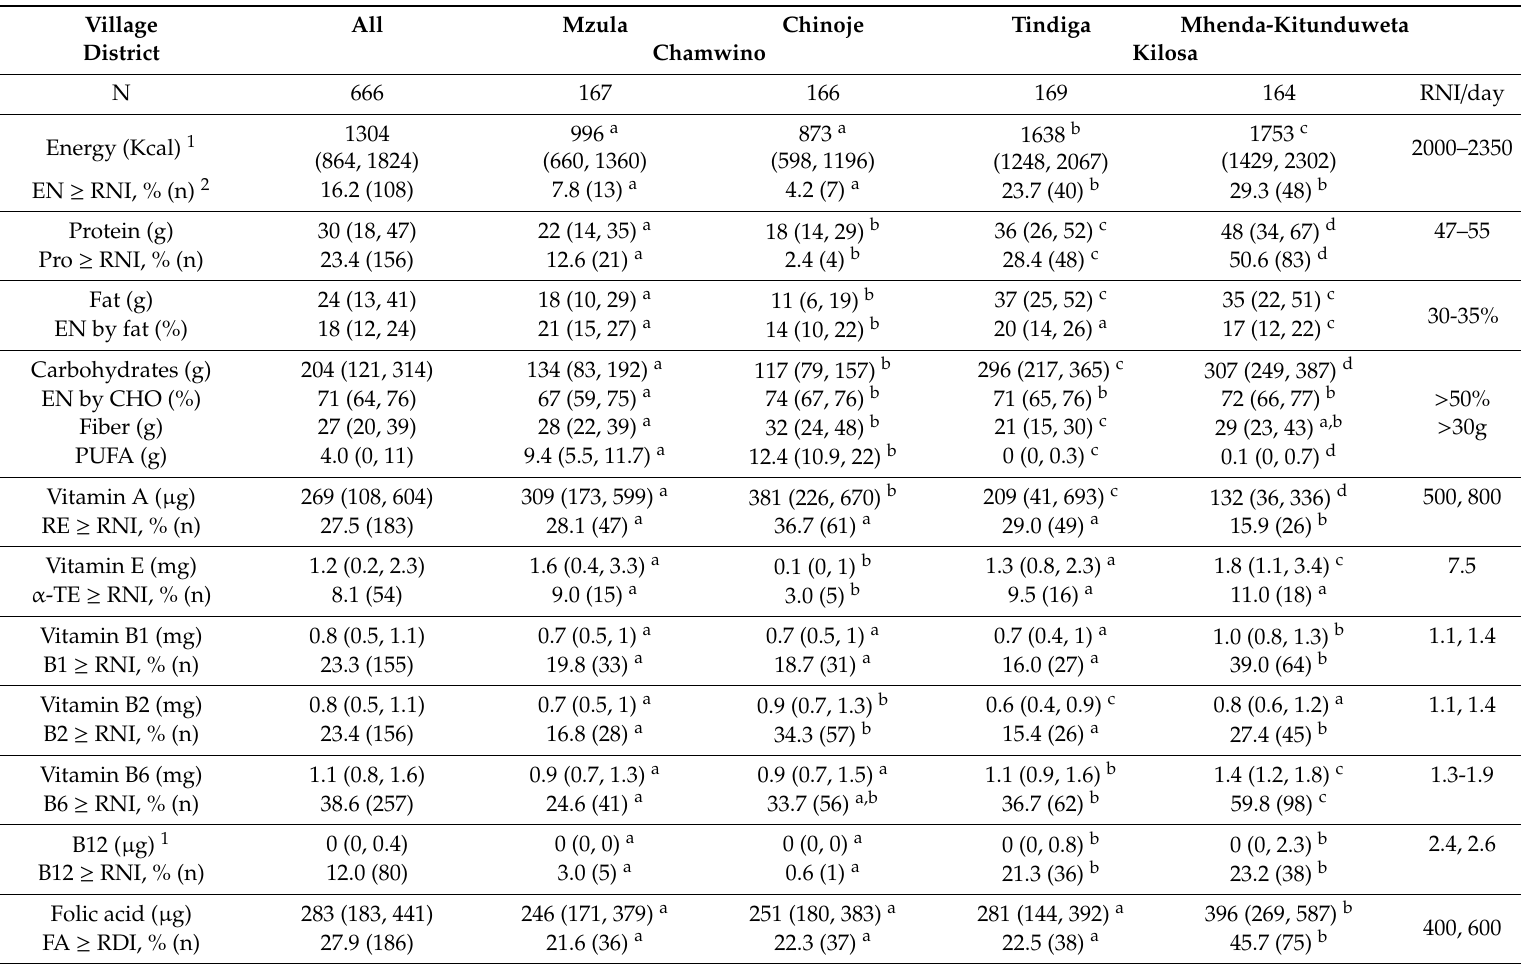
Table 3. Reported macro- and micronutrient intake of mothers and caregivers by villages in comparison to recommended nutrient intakes (RNI). Village All Mzula Chinoje Tindiga Mhenda-Kitunduweta District Chamwino